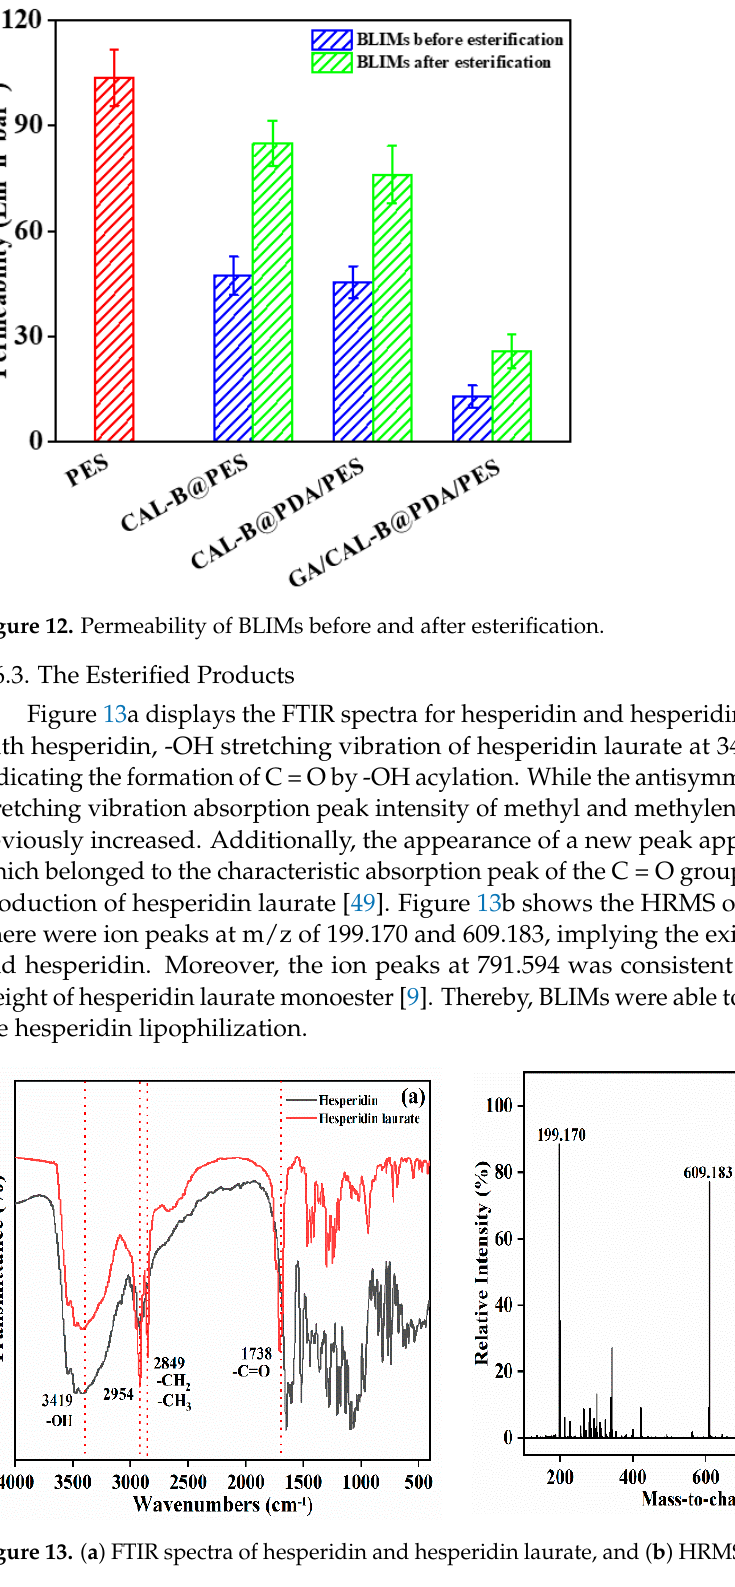
14 of 17 Figure 11. SEM images of BLIMs: ( a ) PES membrane, ( b ) CAL-B@PES, ( c ) CAL-B@PDA/PES, and ( d ) GA/CAL-B@PDA/PES, after esterification. 3.6.2. BLIMs Permeability